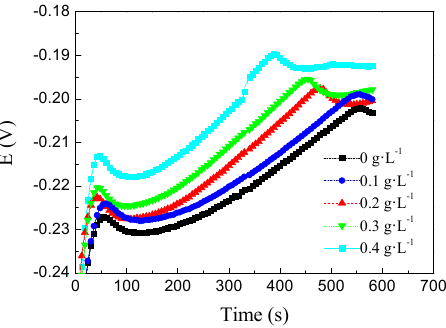
Figure 4. Potential-time curves of 304 stainless steel immersed in coloring solutions with different NiSO 4 concentration. Table 1. The coloring parameters of different specimens.